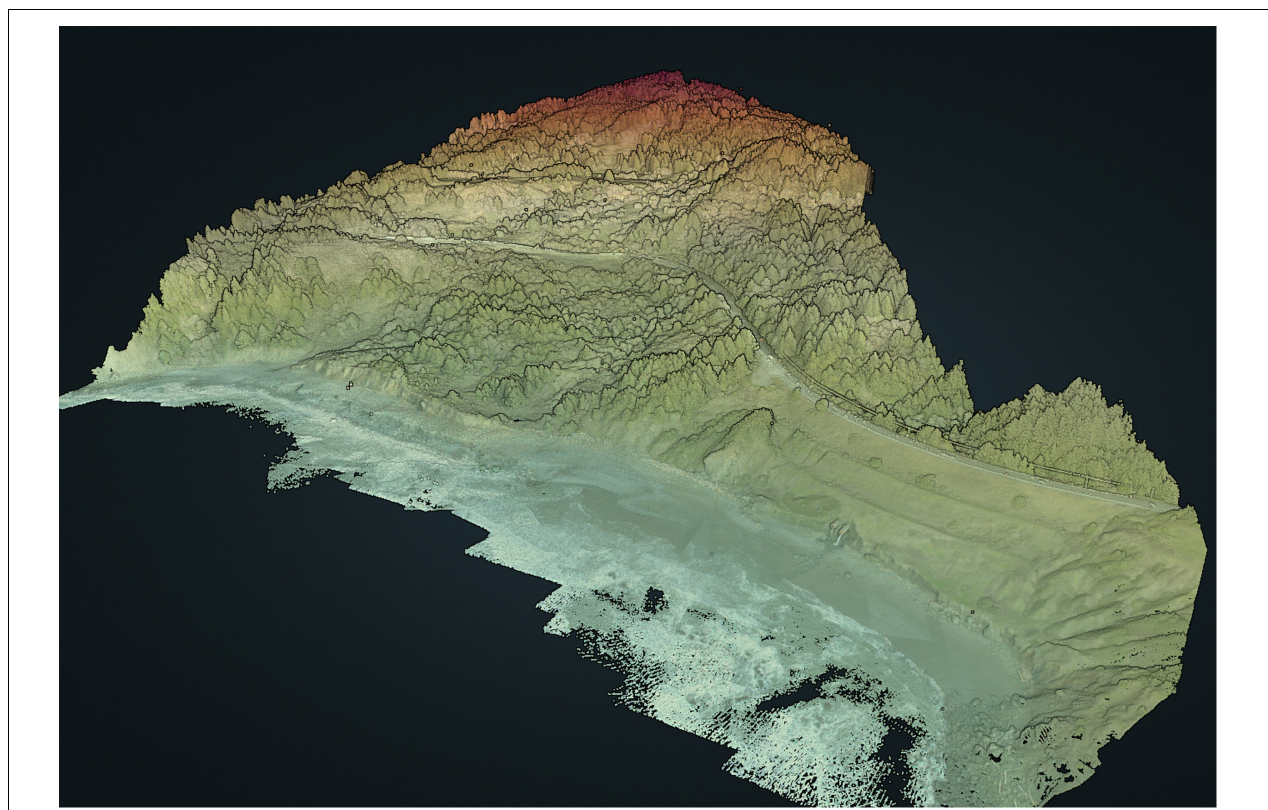
FIGURE 12 | UAS lidar point cloud of the Hooskanaden landslide showing overview with colors blended from elevation and